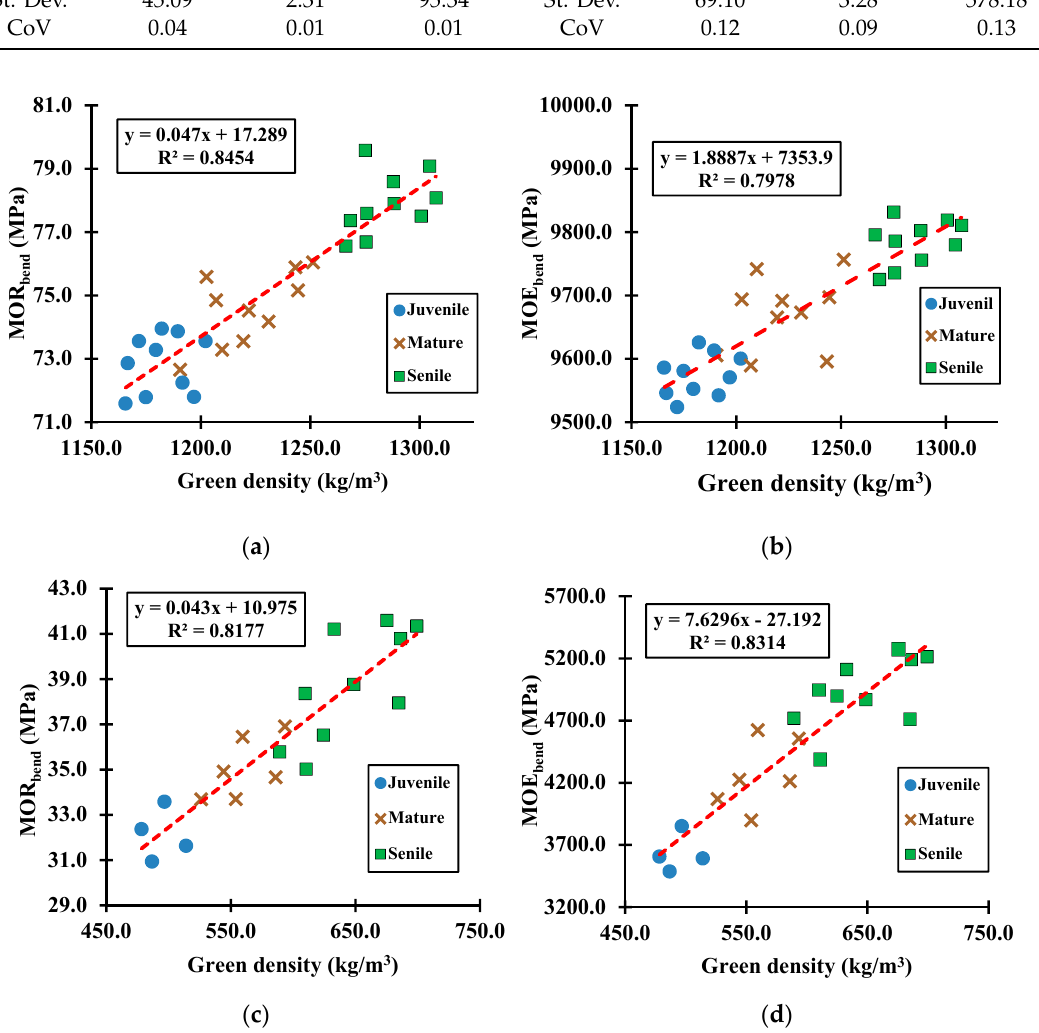
Figure 11. Green samples tested under the bending mode to determine the relationship of green density versus ( a ) MOR for eucalyptus species, ( b ) MOE for eucalyptus species, ( c ) MOR for cypress species, and ( d ) MOE for cypress species.